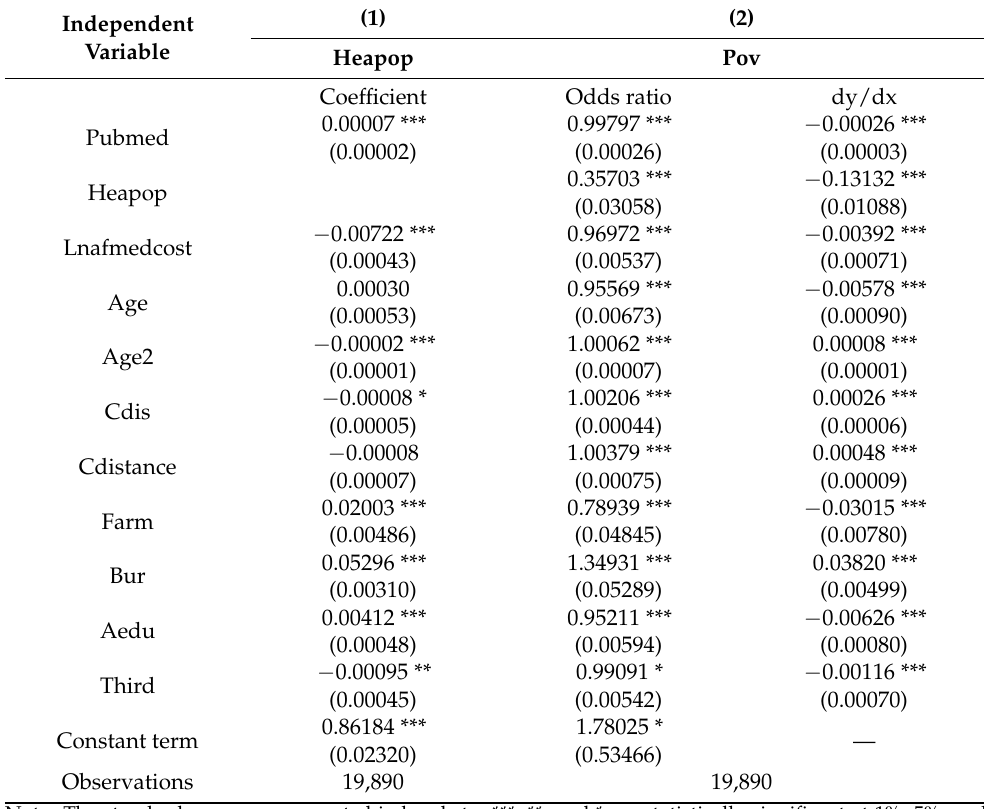
Table 3. Intermediary effect of family health human